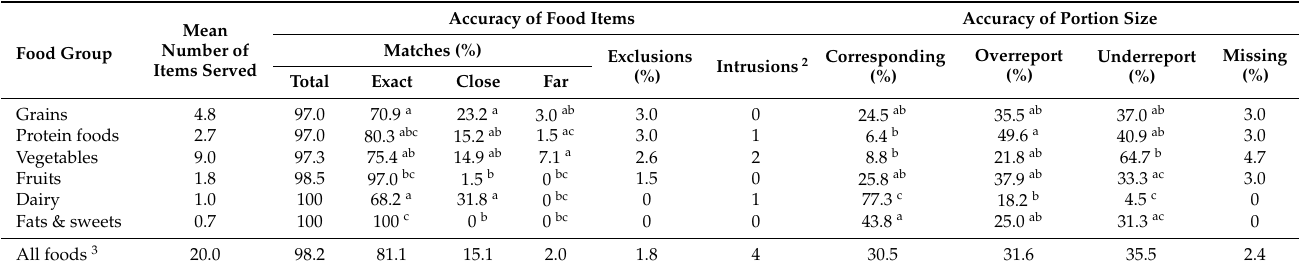
Table 4. Accuracy of food items and portion size of 24-h diet recalls in relation to actual intake according to the food group among older Korean women ( n = 22) 1 .